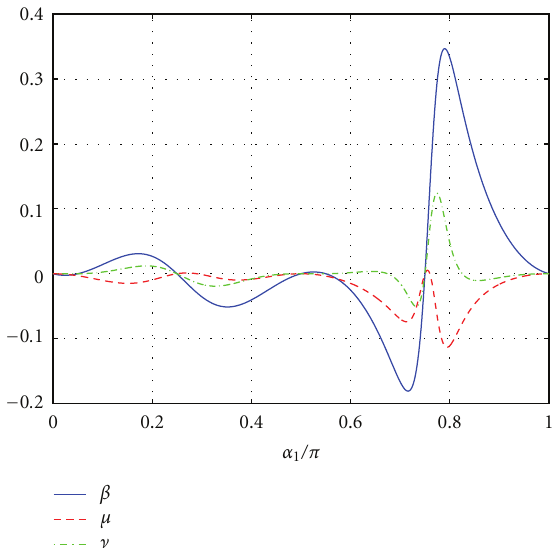
Figure 4: Normalized coe ffi cients of the CQGLE as a function of α 1 at α 2 = 0 . 16 π , α 3 = 0 . 63 π , α p = 0, and K = 0 . 1 (from [44]).